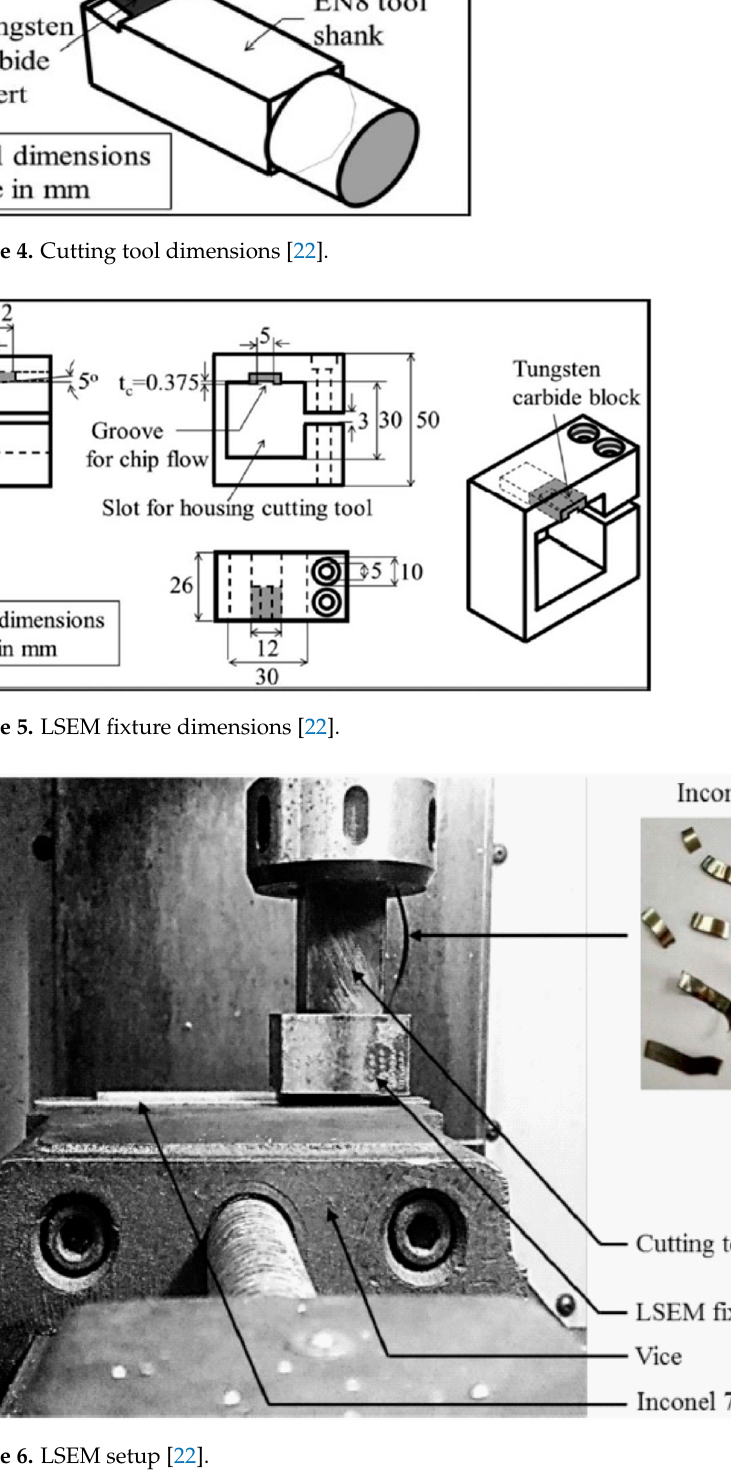
Figure 6. LSEM setup [22].